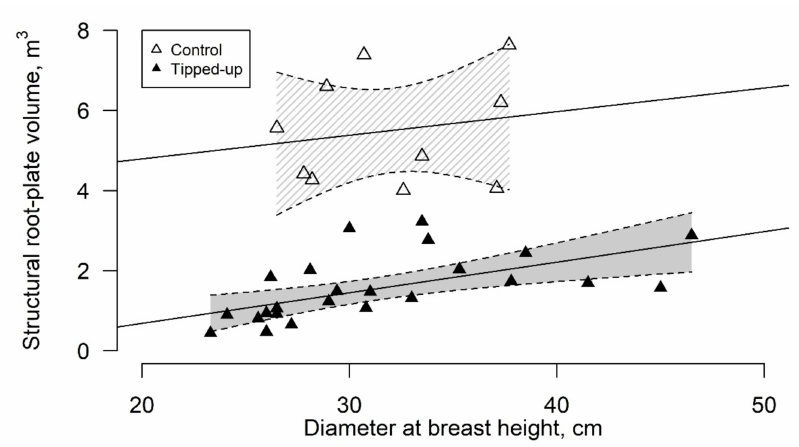
Figure 4. Root-plate volume vs. diameter at breast height in drained deep peat soil. Grey area indicates 95% confidence interval.